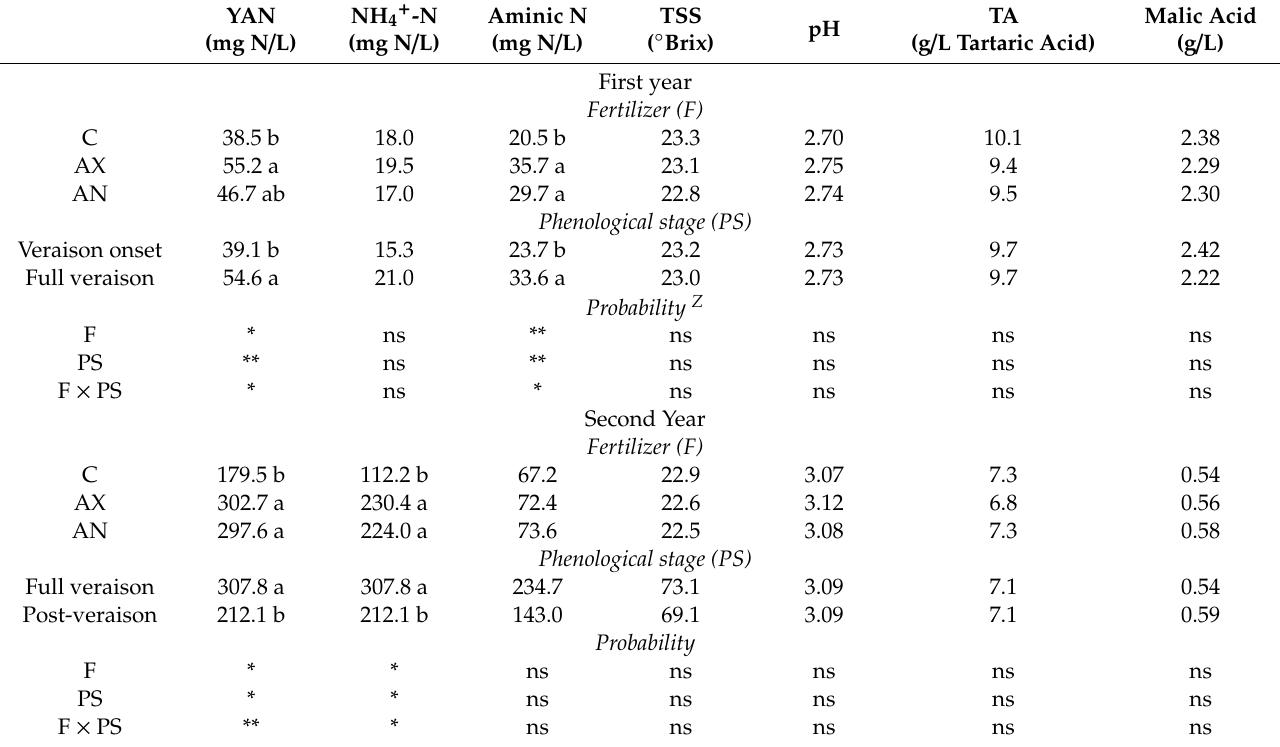
Table 1. Marginal mean for yeast assimilable N (YAN), ammonium N (NH4 + -N), aminic N, total soluble solids (TSS), pH, titratable acidity (TA), and malic acid of berry juice in control vines (C) and vines treated with Aminomax (AX) and Aminoprotein (AN) in two di ff erent phenological stages in 2016 and 2017. The significance of the e ff ect of fertilizer (F), phenological stage of application (PS), and F × PS interaction, measured with two-way analysis of variance is also reported. Marginal means followed by di ff erent letters are significantly di ff erent according to the Duncan’s test ( p ≤ 0.05). The experimental design considered, for each measured parameter, a total of 8 biological replications (n =